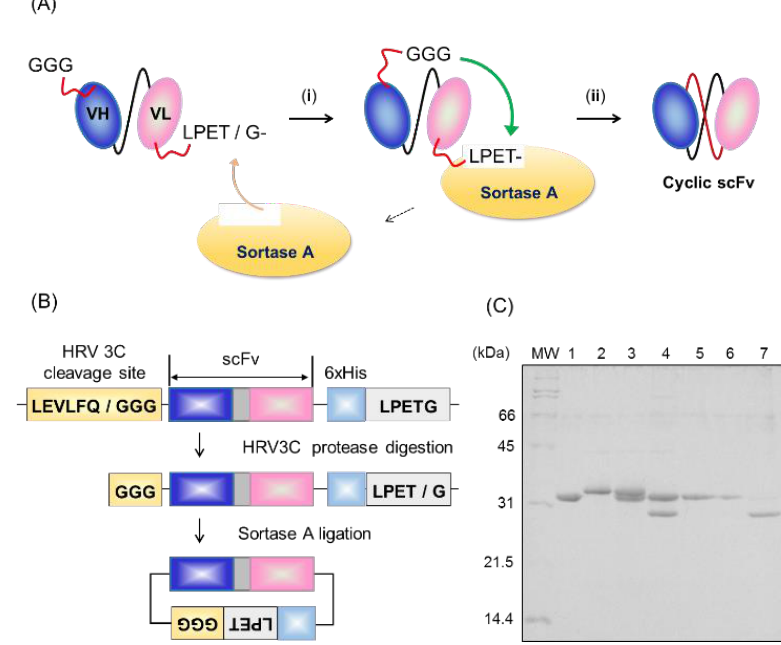
Figure 2. ( A ) Scheme for sortase A-mediated scFv cyclization. (i) Sortase A cleaves the peptide bond between threonine and glycine of the C-terminal LPETG motif, which leads to the formation of a covalent thioester bond between sortase A and its substrate. (ii) This thioester bond is rapidly resolved by nucleophilic attack of the N-terminal glycine residue, resulting in the generation of a cyclic scFv connected N-terminus and C-terminus covalently. ( B ) Schematic representation of the protocol for the preparation of cyclic scFv. The N-terminal tri-glycine was exposed by HRV3C protease digestion. The hexa-histidine tag was inserted in front of the LPETG motif to separate the cyclic scFv and sortase A. ( C ) SDS-PAGE analysis of sortase A-mediated scFv cyclization. Lane 1, sortase A; lane 2, 13C7-scFv-LPETG; lane 3, before sortase A reaction; lane 4, after the reaction at 25 °C for 1 h; lane 5, flow-through fraction of Ni-NTA affinity chromatography; lane 6, wash fraction; lane 7, elution fraction.